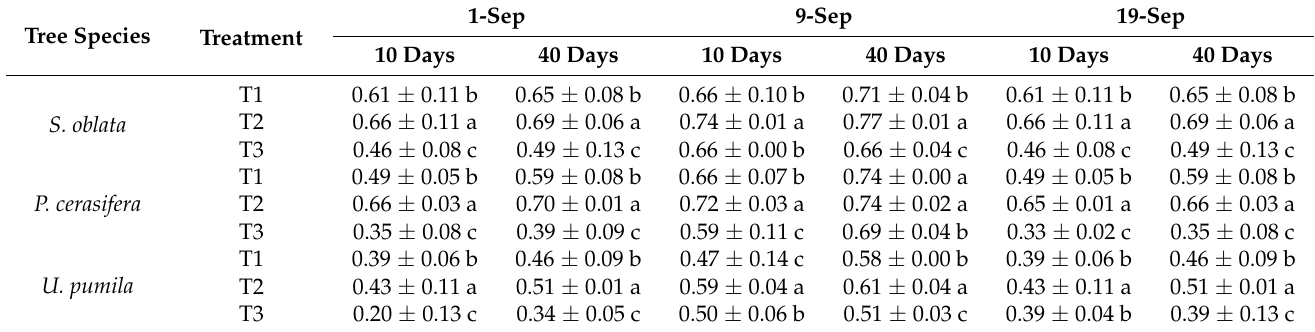
Table 5. Maximum quantum yield of photosystem II (Fv/Fm) for 10 days old leaves and the lower 40 days old leaves on 1 September, 9 September, and 19 September 2019 for S. oblate, P. cerasifera and U. pumila grown under three different SO 2 treatments (T1–T3). Within each treatment and date, statistical differences between 10 days and 40 days ( p < 0.05) are denoted with the lower case letters a, b, and c. Data represent means ± SE ( n =